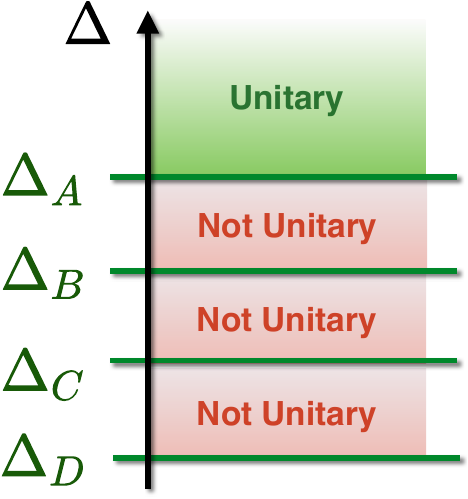
Figure 1 . Hierarchy of unitary long and short multiplets. Long multiplets exist when (cid:1) > (cid:1) A . Their continuum extends down to short A -type multiplets with (cid:1) = (cid:1) A . Isolated short multiplets exist when (cid:1) = (cid:1) B;C;D , but not if (cid:1) lies in a gap between (cid:1) A > (cid:1) B > (cid:1) C > (cid:1) D